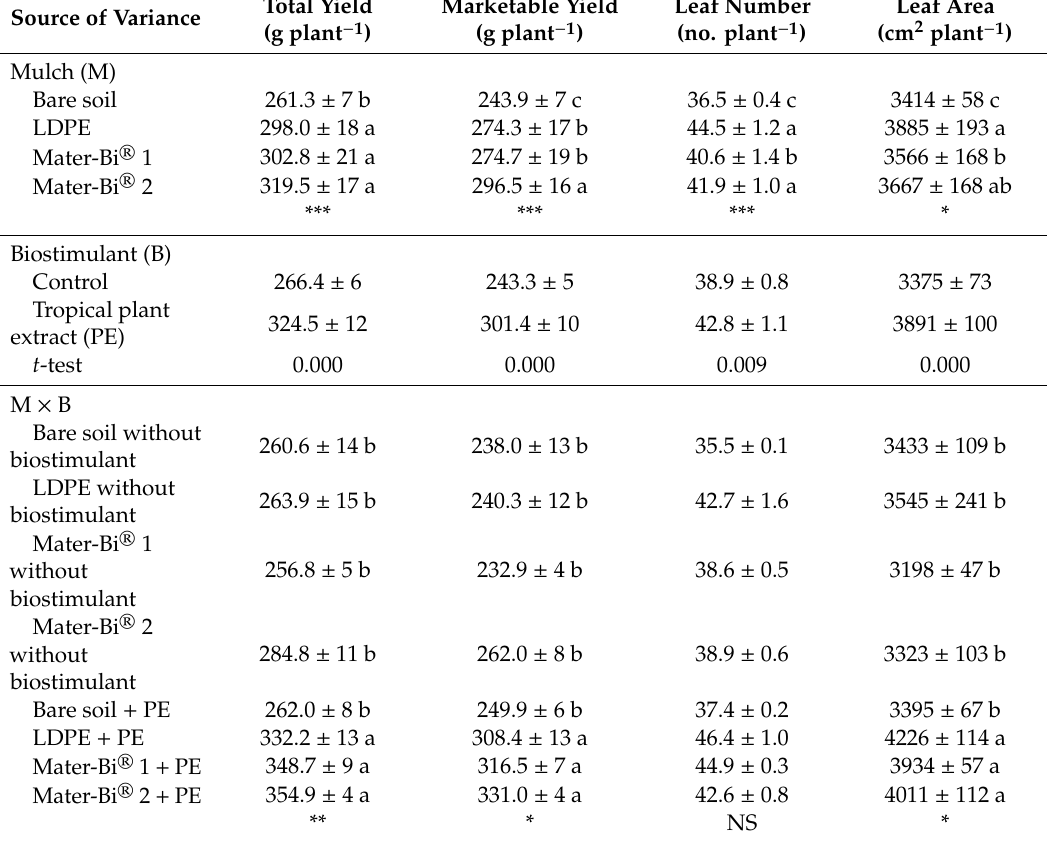
Table 1. Mean comparison and analysis of variance for total and marketable yield, leaf number, and total leaf area of untreated and biostimulant-treated greenhouse lettuce grown under low-density polyethylene (LDPE) mulch and biodegradable (Mater-Bi ® 1 and Mater-Bi ® 2) mulching materials in relation to bare